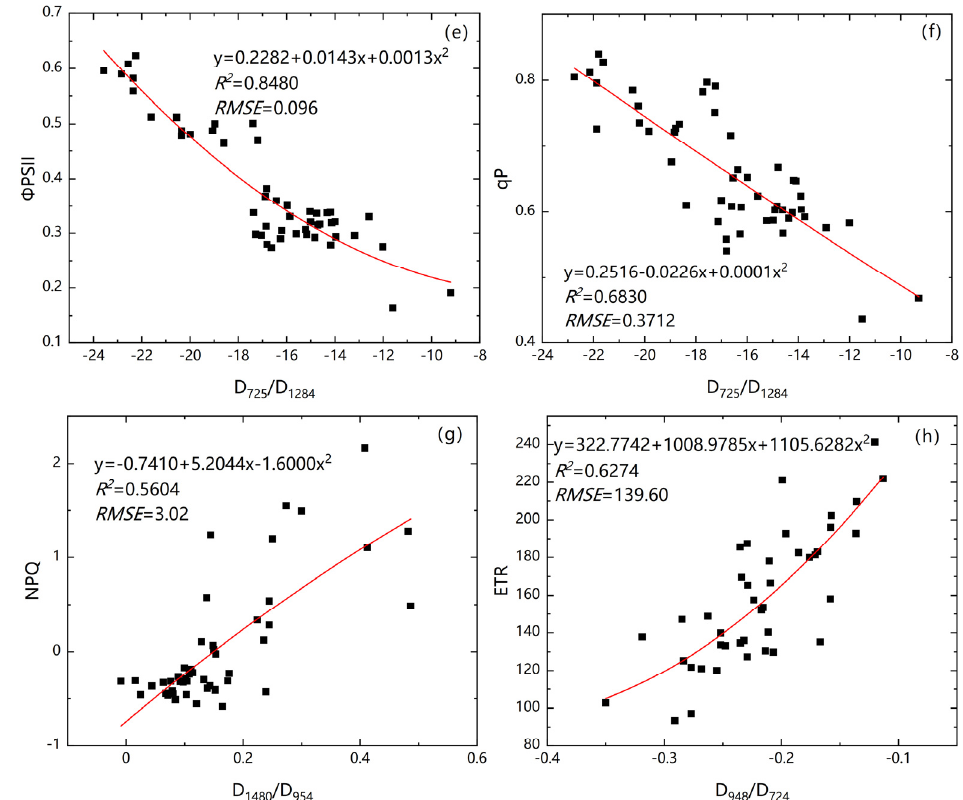
Figure 10. Fitting relationship diagram between the vegetation index with the highest correlation and the corresponding chlorophyll fluorescence parameter. ((a)fitting equation of D 690 /D 1320 and 𝐹𝑣/𝐹𝑚 ;(b) fitting equation of D 980 /D 1284 and 𝐹𝑜′ ;(c) fitting equation of D 486 /D 668 and 𝐹𝑚′ ;(d) fitting equation of D 725 /D 1284 and 𝐹𝑣′/𝐹𝑚′ ;(e) fitting equation of D 725 /D 1284 and 𝛷𝑃𝑆𝐼𝐼 ;(f) fitting equation of D 725 /D 1284 and 𝑞𝑃 ;(g) fitting equation of D 1480 /D 954 and 𝑁𝑃𝑄 ;(h) fitting equation of D 948 /D 724 and 𝐸𝑇𝑅 ). The red curve represents the best fit line.